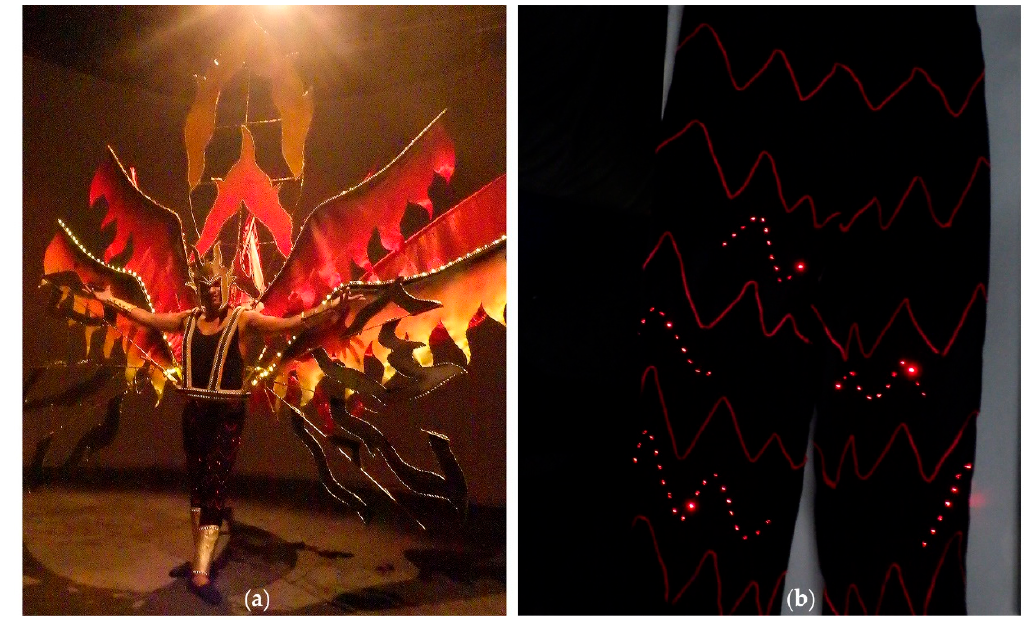
Figure 6. The completed costume. ( a ) The full costume incorporating the unitard, worn by Gil Santos. ( b ) A detail of the LED-yarns on the unitard legs, shown on a mannequin.